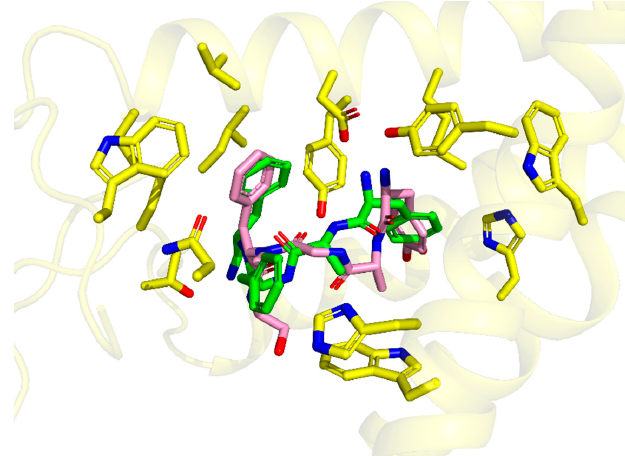
Figure 3. Comparison of the binding modes of DAMGO (from 6DDF PDB structure [31], pink sticks) and TAPP (from docking, green sticks). The picture is oriented in the same projection as Figure 2. Only several side-chains of the receptor binding site (yellow sticks) are shown.